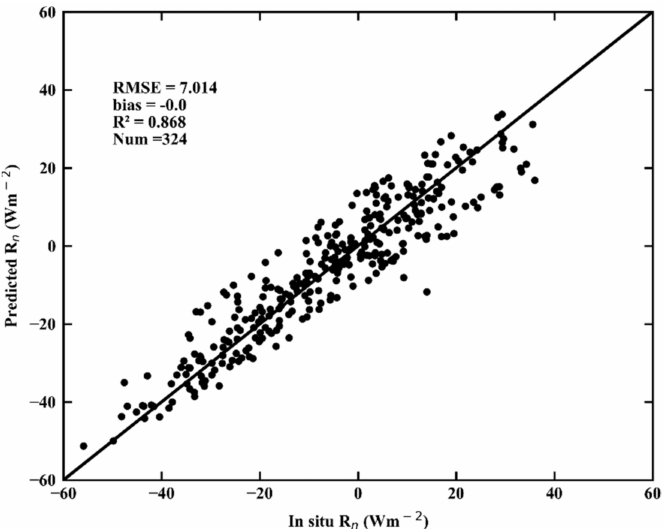
Figure 8. Fitting accuracy of Equation (15).